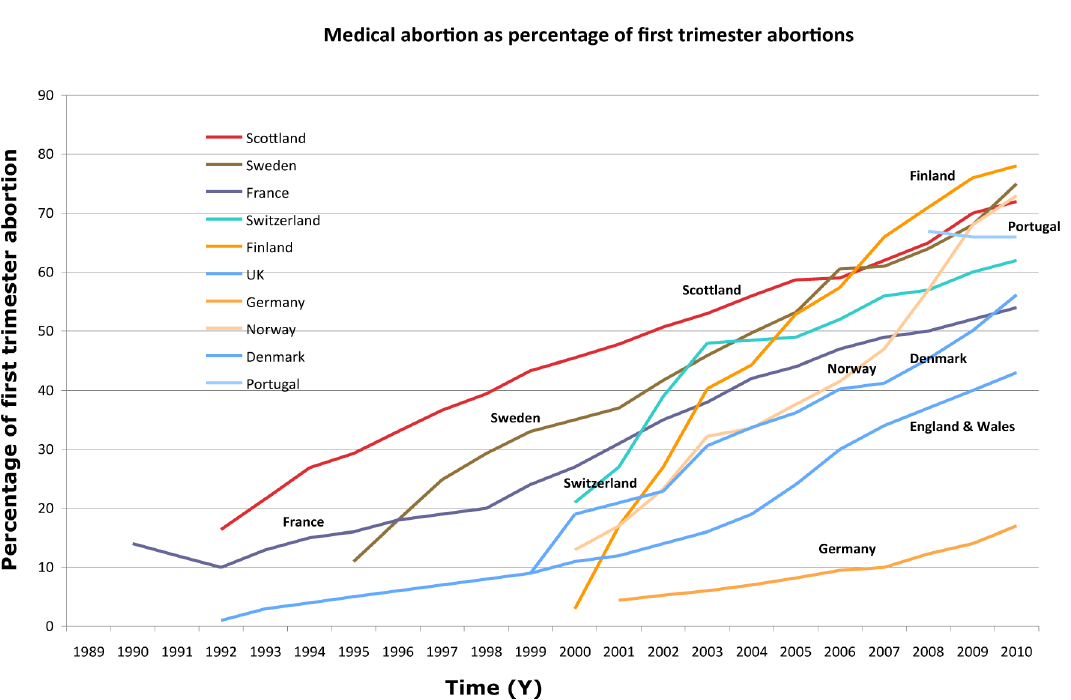
Fig. 1. Change over time in medical abortion as percentage of first trimester abortions. Note below the figure: references regarding figures may be found at the following addresses. Scotland: http://www.isdscotlandarchive.scot.nhs.uk/isd/6207.html; Sweden: http://www.socialstyrelsen.se/statistik/ statistikefteramne/aborter; France: http://www.drees.sante.gouv.fr/les-interruptions-volontaires-de-grossesse-en-2011,11149.html; Switzerland: http://www. bfs.admin.ch/bfs/portal/de/index/themen/14/02/03/key/03.html; Finland: www.stakes.fi/; UK: https://www.gov.uk/government/collections/abortion-statistics- for-england-and-wales; Germany: https://www.destatis.de/DE/ZahlenFakten/GesellschaftStaat/Gesundheit/Schwangerschaftsabbrueche/ Schwangerschaftsabbrueche.html; Norway: http://www.ssb.no/en/abort; Denmark: http://www.dst.dk/da/; Portugal: http://www.spdc.pt/files/Relatorio_ Interrupo_de_gravidez_2012.pdf.